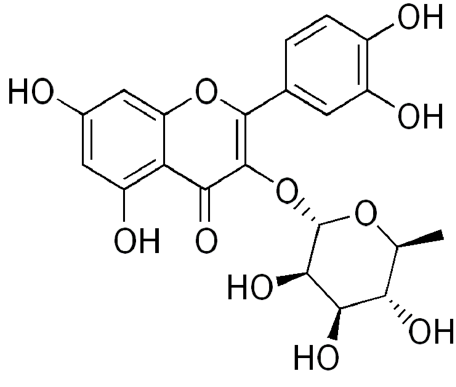
Figure 2. Quercetrin.